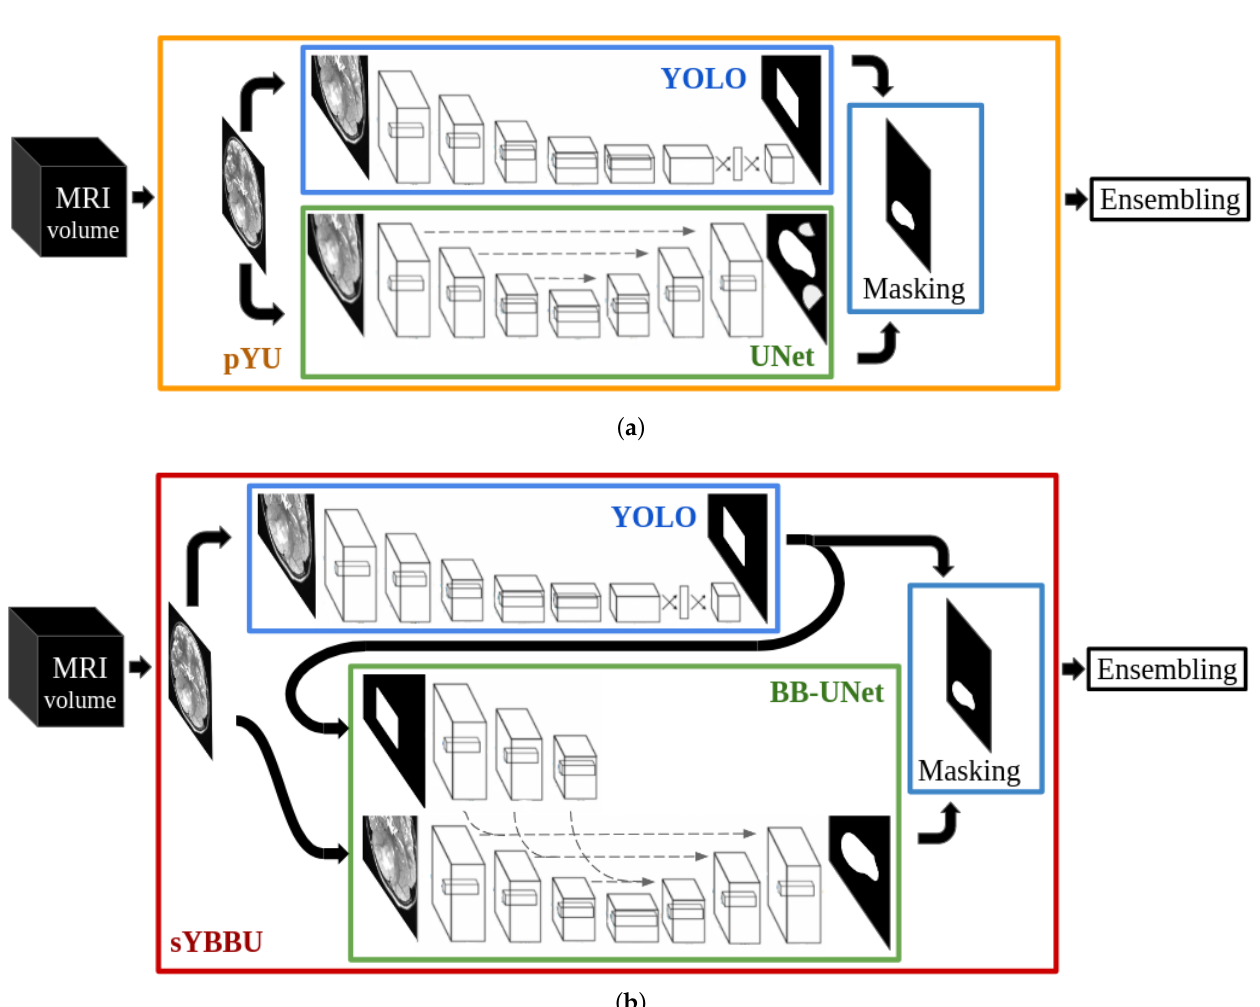
Figure 2. The two approaches pYU and sYBBU. ( a ) Parallel YOLO UNet (pYU) model; ( b ) Sequential YOLO BB-UNet (sYBBU)